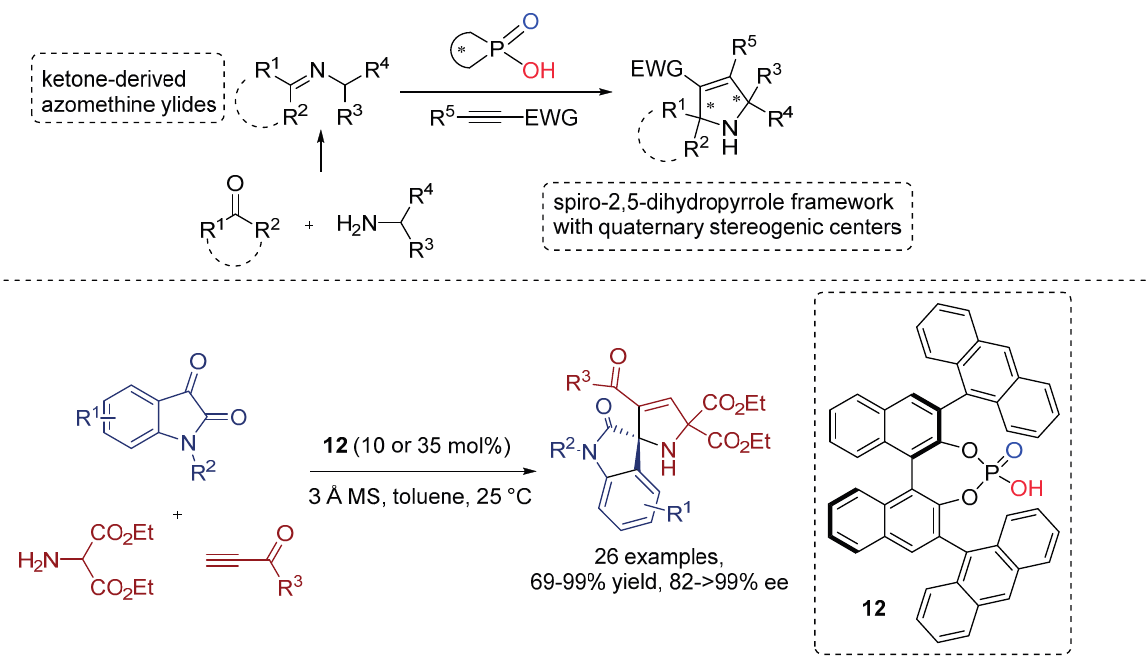
Scheme 11. 1,3-Dipolar cycloaddition of alkynes with isatin-derived azomethine ylides.